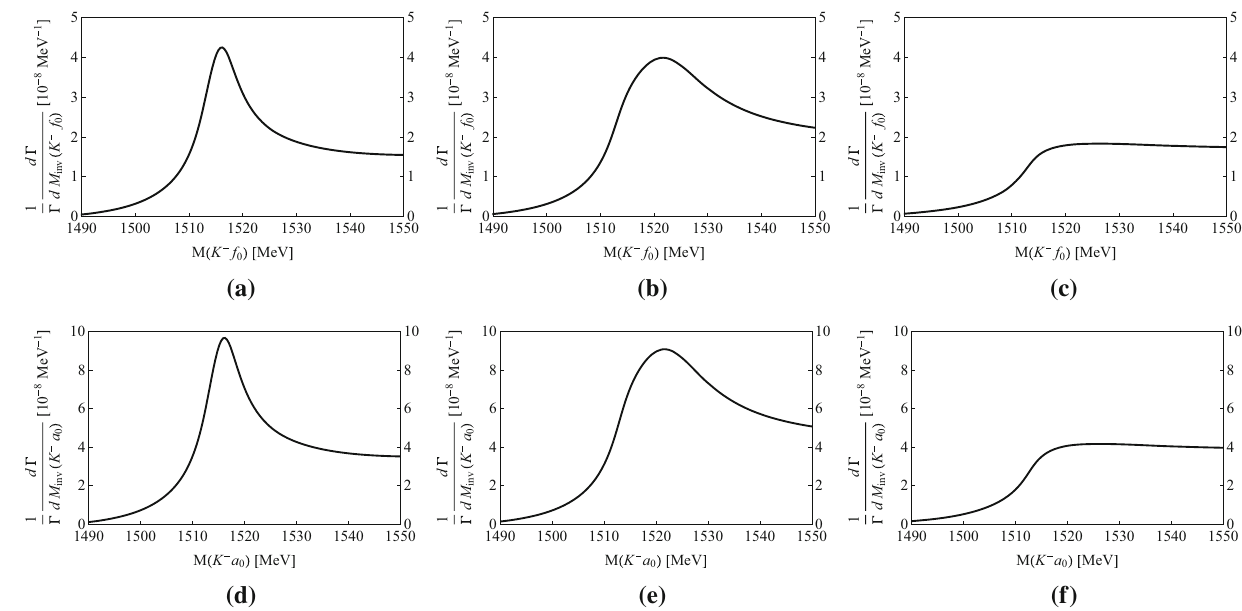
d Γ J /ψ → K + K − f 987 MeV, and f m a 0 ( a 0 ) , defined dM inv ( K − f 0 / K − a 0 ) J /ψ tion, and for a 0 production one multiplies it by ( g a = 989 MeV, 0 = 989 MeV, e m = a 0 a 0